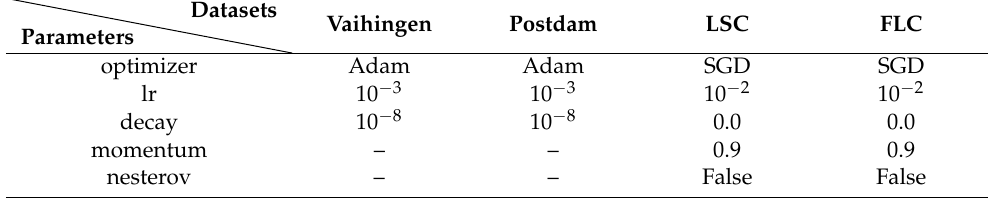
Table 1. Training parameters of